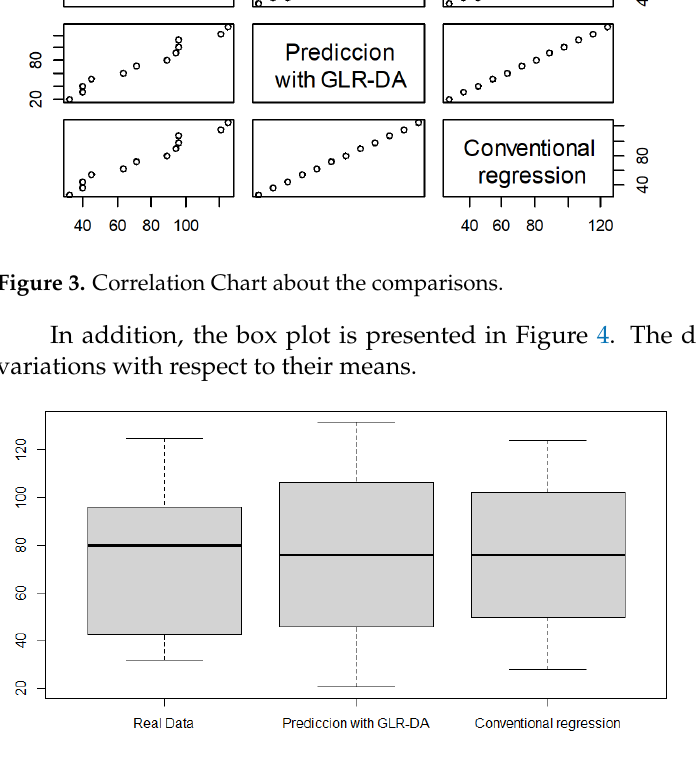
Figure 4. Box Plot Chart.